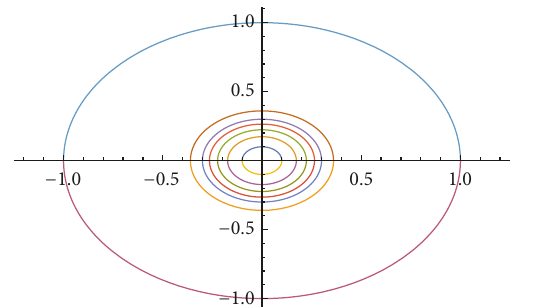
Figure 8: When 𝑐 = 1 , an invariant algebraic curve 𝑥 2 + 𝑦 2 = 1 and six small limit cycles.